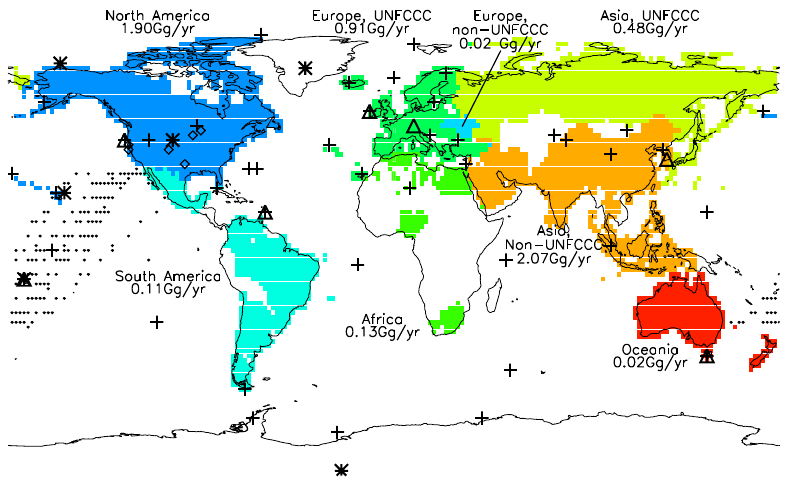
Fig. 3. Eight regions whose emissions were estimated in our regional inversion. Colored areas show grid cells (1.8 ◦ × 1.8 ◦ resolution) where EDGAR predicts non-zero emissions. Measurement locations are shown for AGAGE (triangles), NOAA in situ (asterisks), tower (diamonds), surface flask sites (crosses) and NOAA Pacific Ocean Cruise tracks (dots). The site location shown here refers to the assumed position within the model and may differ from the true location as outlined in the text. The quoted emissions are the regional EDGAR v4 estimates for